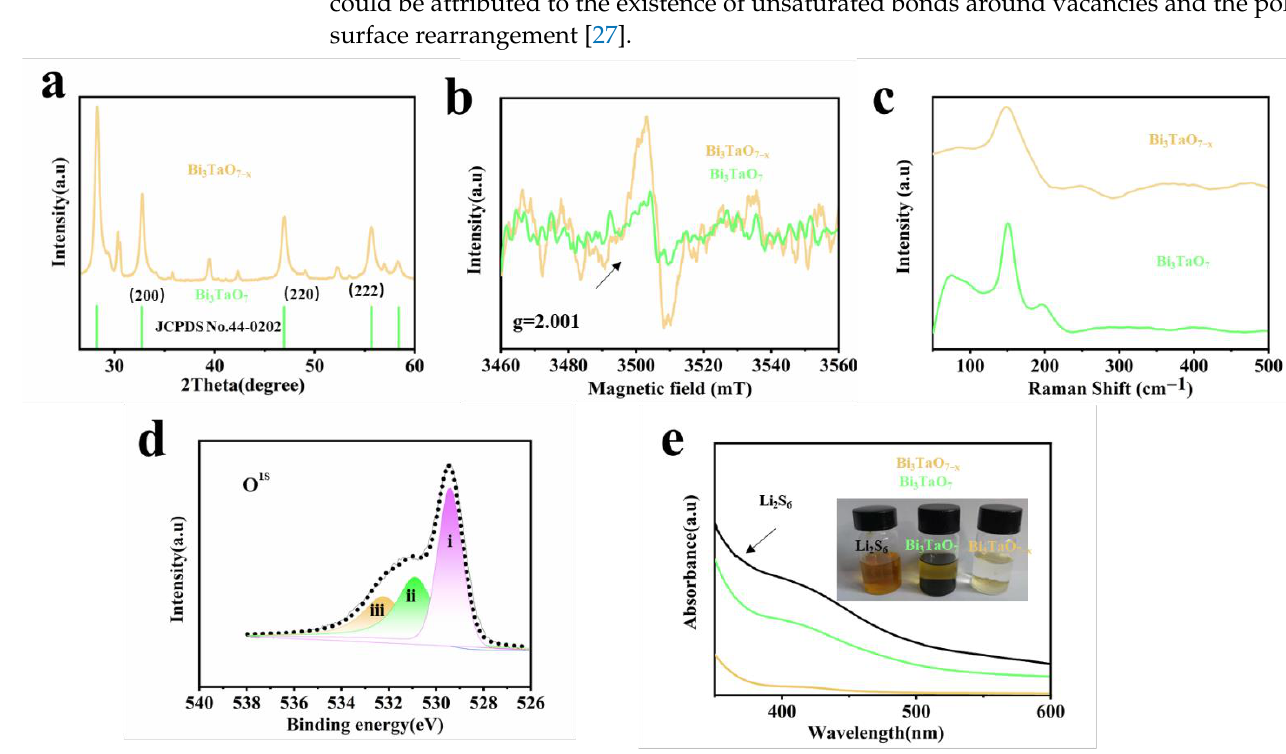
Figure 3. ( a ) XRD patterns of the Bi 3 TaO 7 − x and Bi 3 TaO 7 . ( b ) EPR spectra of the Bi 3 TaO 7 − x and Bi 3 TaO 7 . ( c ) Raman spectra of the Bi 3 TaO 7 − x and Bi 3 TaO 7 . ( d ) High-resolution O1s XPS spectra of the Bi 3 TaO 7 − x .